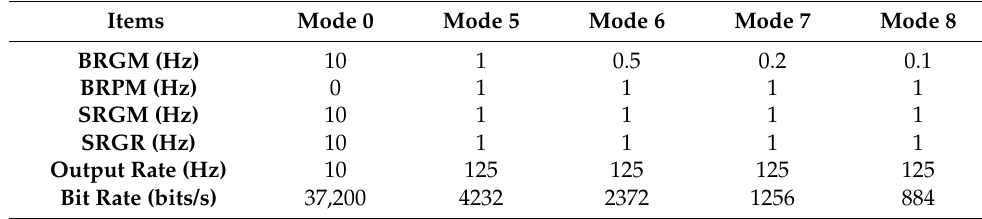
Table 6. Modes of sampling and broadcast rate in test 2.